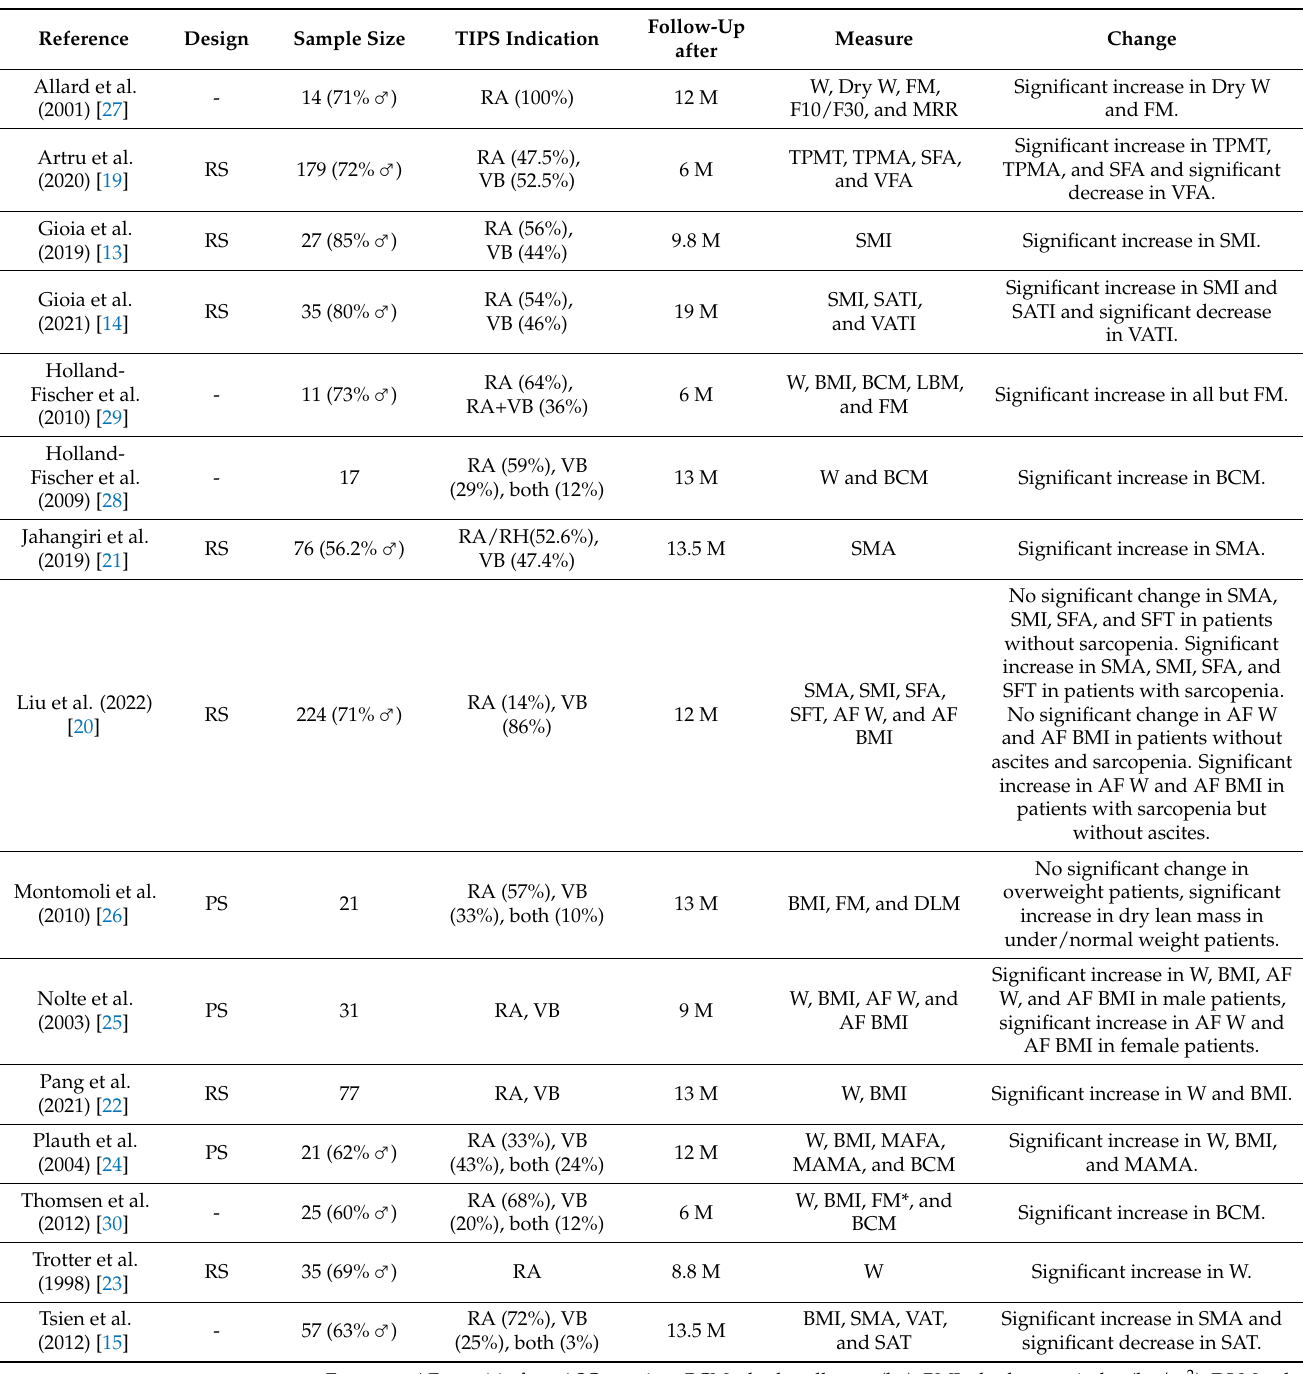
Table 1. Main changes in the nutritional status after transjugular intrahepatic portosystemic shunt placement in cirrhotic